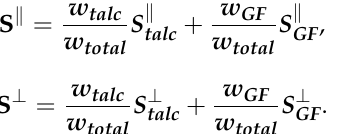
Figure 19. Regression analysis plot for the shrinkage of PP/GF: ( a ) Shrinkage in the flow direction, and ( b ) shrinkage in the transverse direction. Table 12. Shrinkage prediction by regression analysis. No.